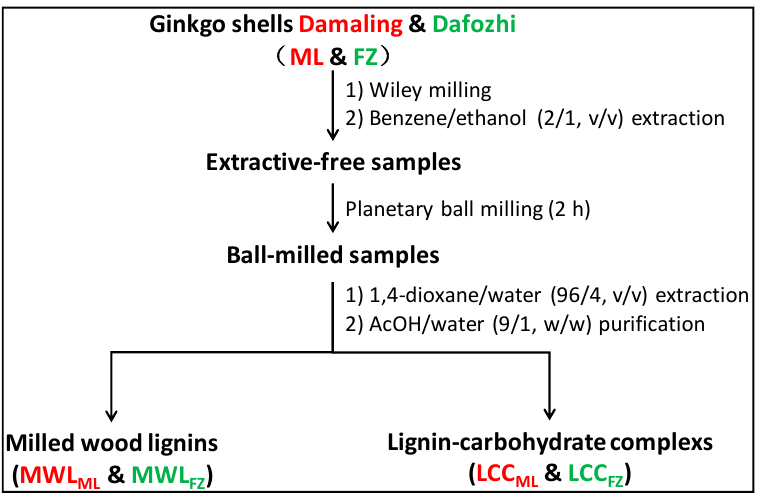
Figure 1. Isolation procedure of MWLs and LCCs from ginkgo shells.